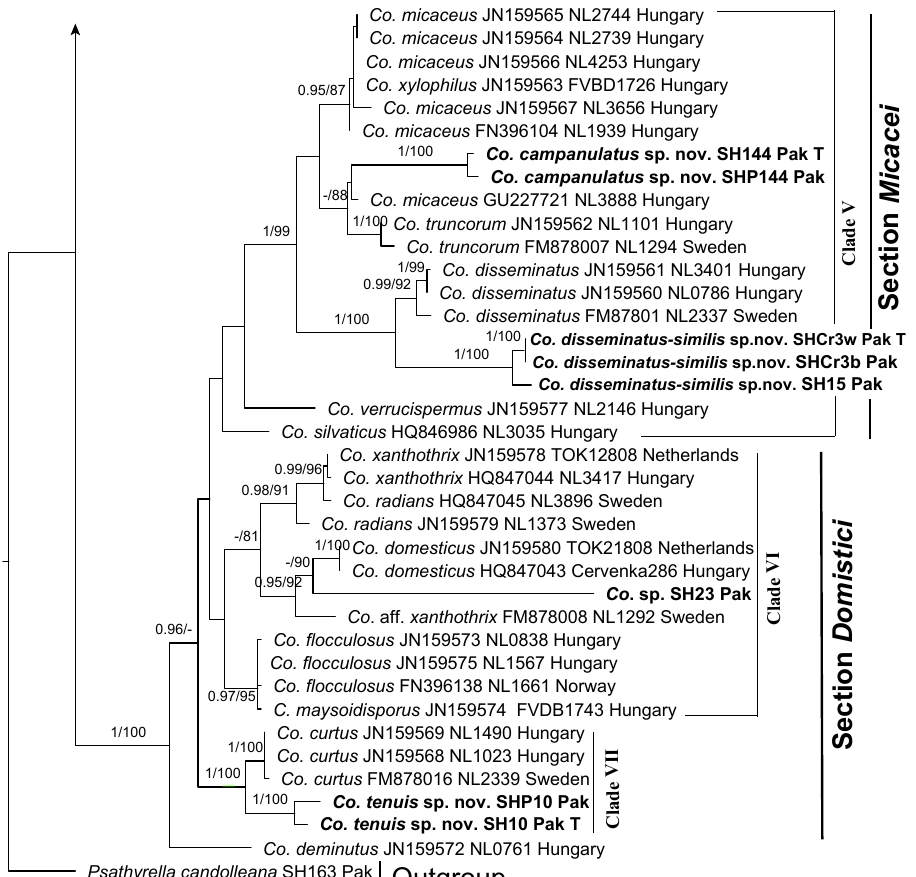
Diagnosis. The diagnostic features of Coprinellus campanulatus are: campanulate pi- leus with greyish-olive tinge, surface with glistening clusters of micaceous veil at ma- turity, dark yellowish-brown centre, basidiospores 8.0–10.5 × 5.5–6.5 × 4.5–5.5 µm, spores mitriform in face view and cylindrical to amygdaliform in side